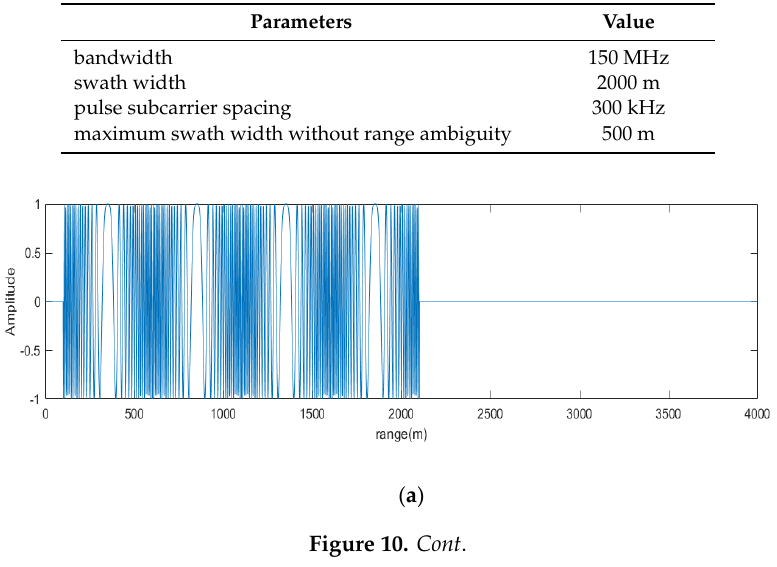
Table 1. Parameters Used in Figure 10 and Figure 11.